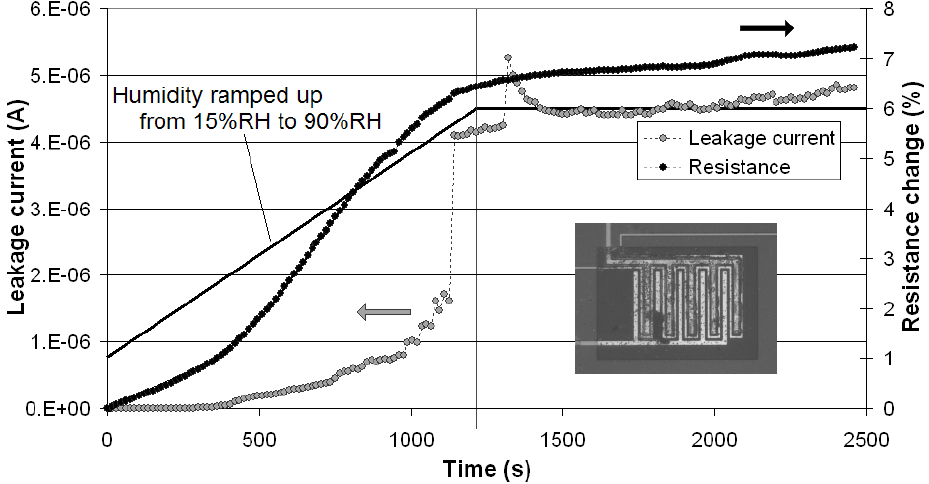
Figure 14. Corrosion rate of an 800 µm long triple track structure (3.3V bias). Inset: The same structure fully corroded after several days (optical microscope